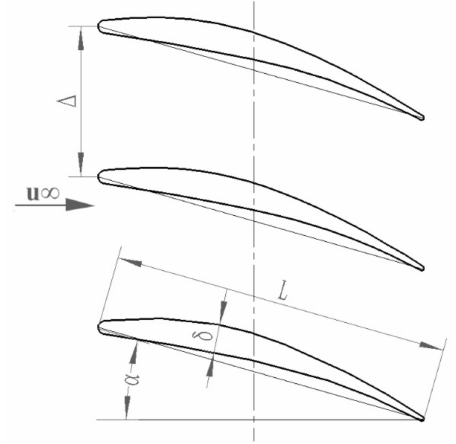
Figure 7. Key parameters of a shutter-like fairing